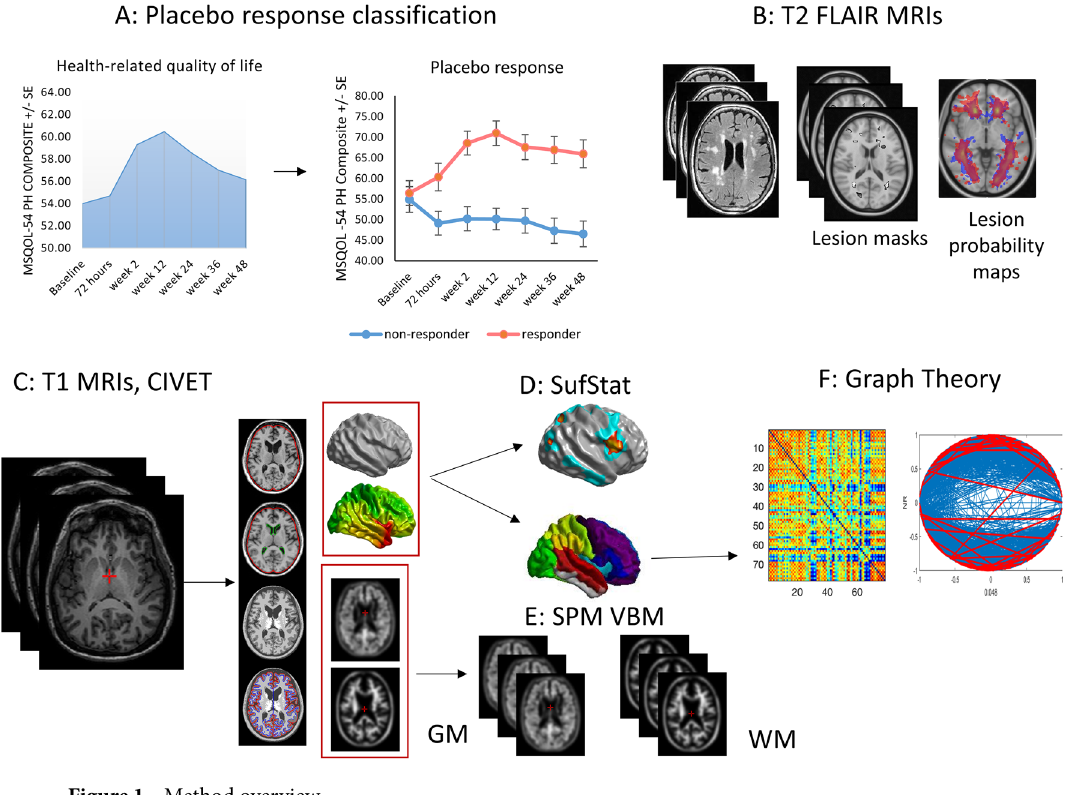
Figure 1. Method